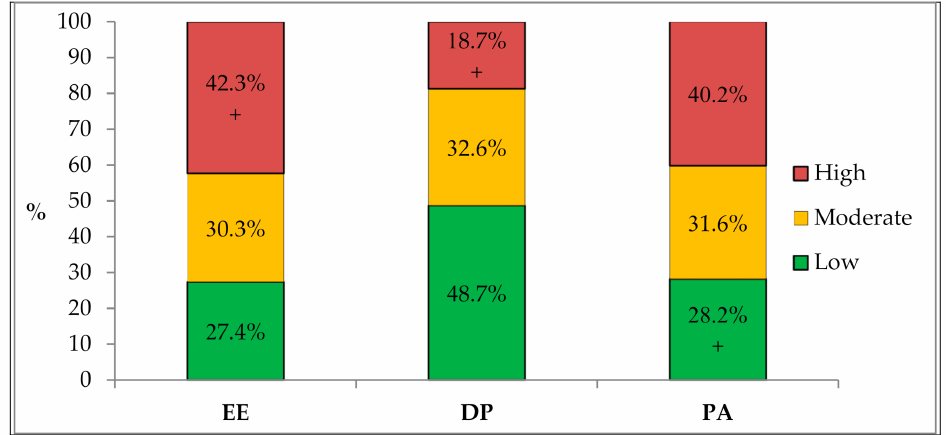
Figure 1. Sum score levels by MBI dimensions. Abbreviations: EE—emotional exhaustion; DP— depersonalization; PA—personal accomplishment. “+” indicates proportions assigned to high